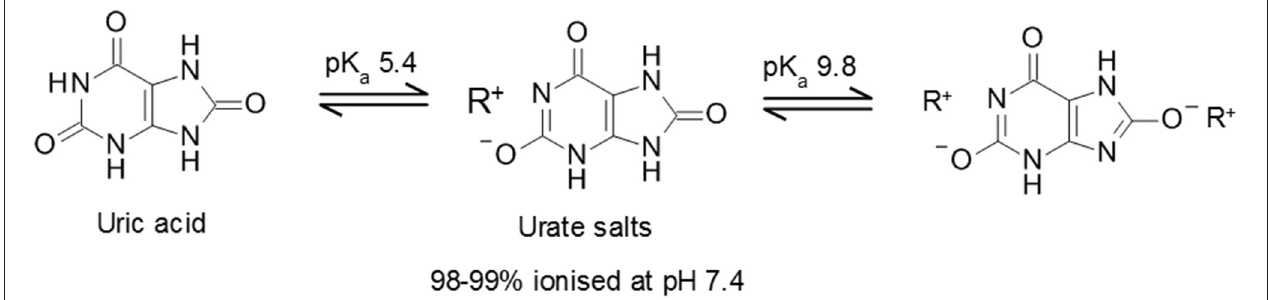
FIGURE 2 | Biosynthesis of uric acid from purines. Purine mononucleotides are catabolized to produce uric acid although the underlying pathway can vary in different tissues and cells. A schematic example pathway is shown.